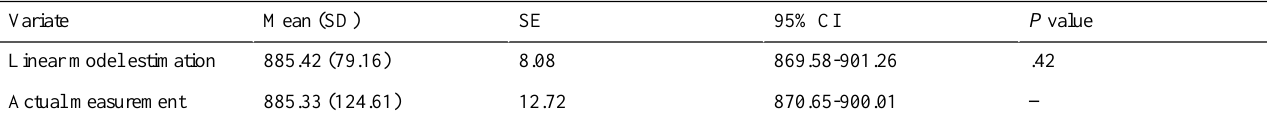
Table 4. Comparison of linear model estimation results and actual measurements of finish times for 3000-meter runs (n=96).